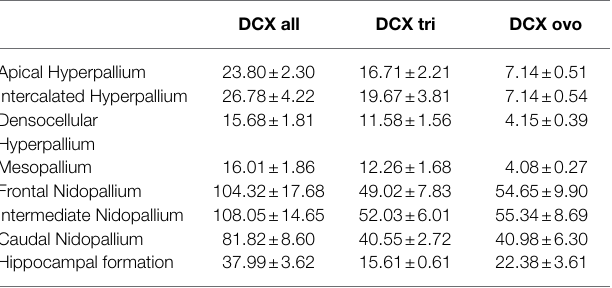
TABLE 3 | Distribution of DCX+ cells/mm 2 in different telencephalic regions of the